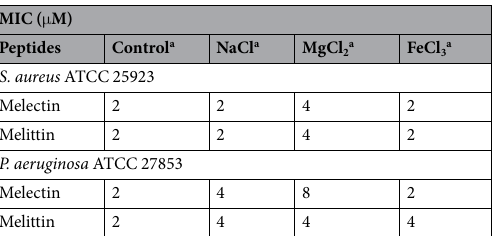
Table 3. Minimum inhibitory concentration (MIC) of melectin at various salt concentrations. a The final concentrations of NaCl, MgCl 2 , and FeCl 3 were 150 mM, 1 mM, and 4 μ M, respectively, and the control was a 10 mM sodium phosphate buffer (pH